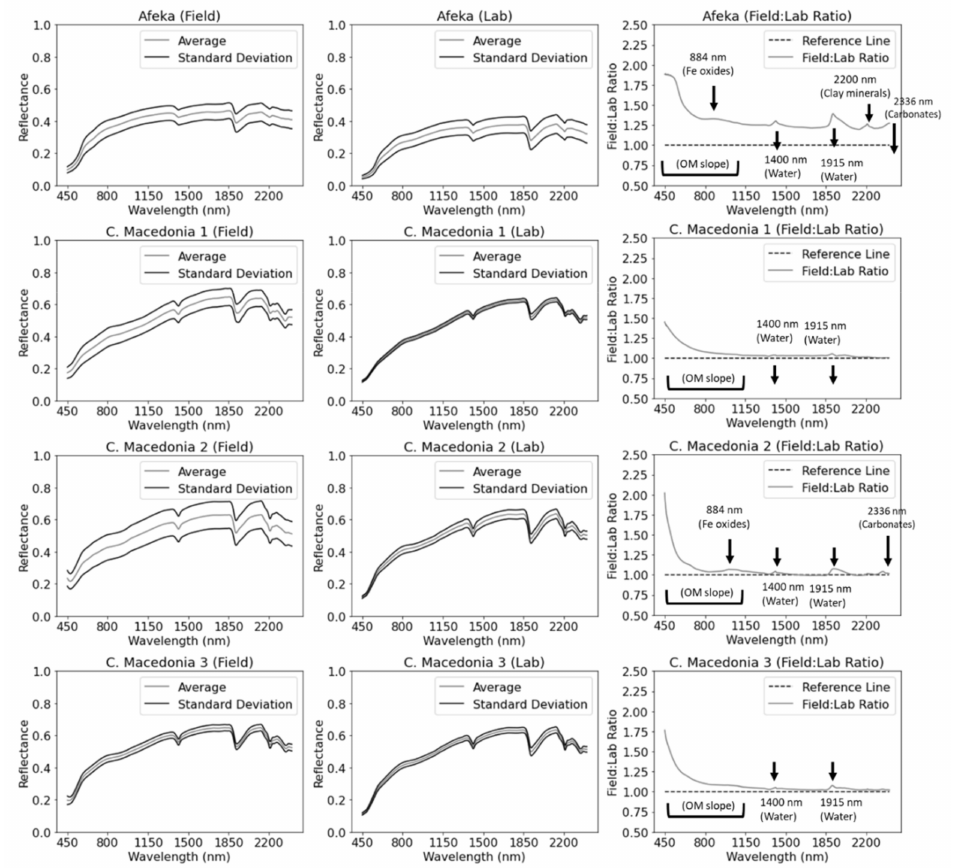
Figure 5. Average reflectance obtained in the field and laboratory and average spectral ratio between field and laboratory spectral measurements (per field) for the sandy group.